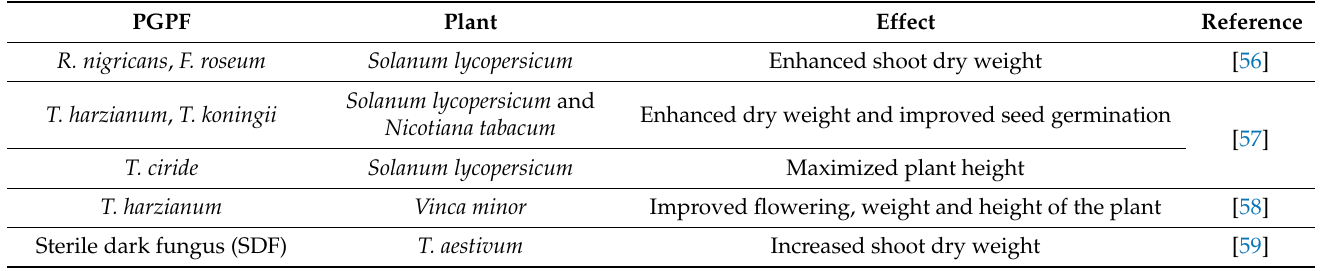
Table 1. Mechanism of plant growth promotion mediated by PGPF in different crop plants. PGPF Plant